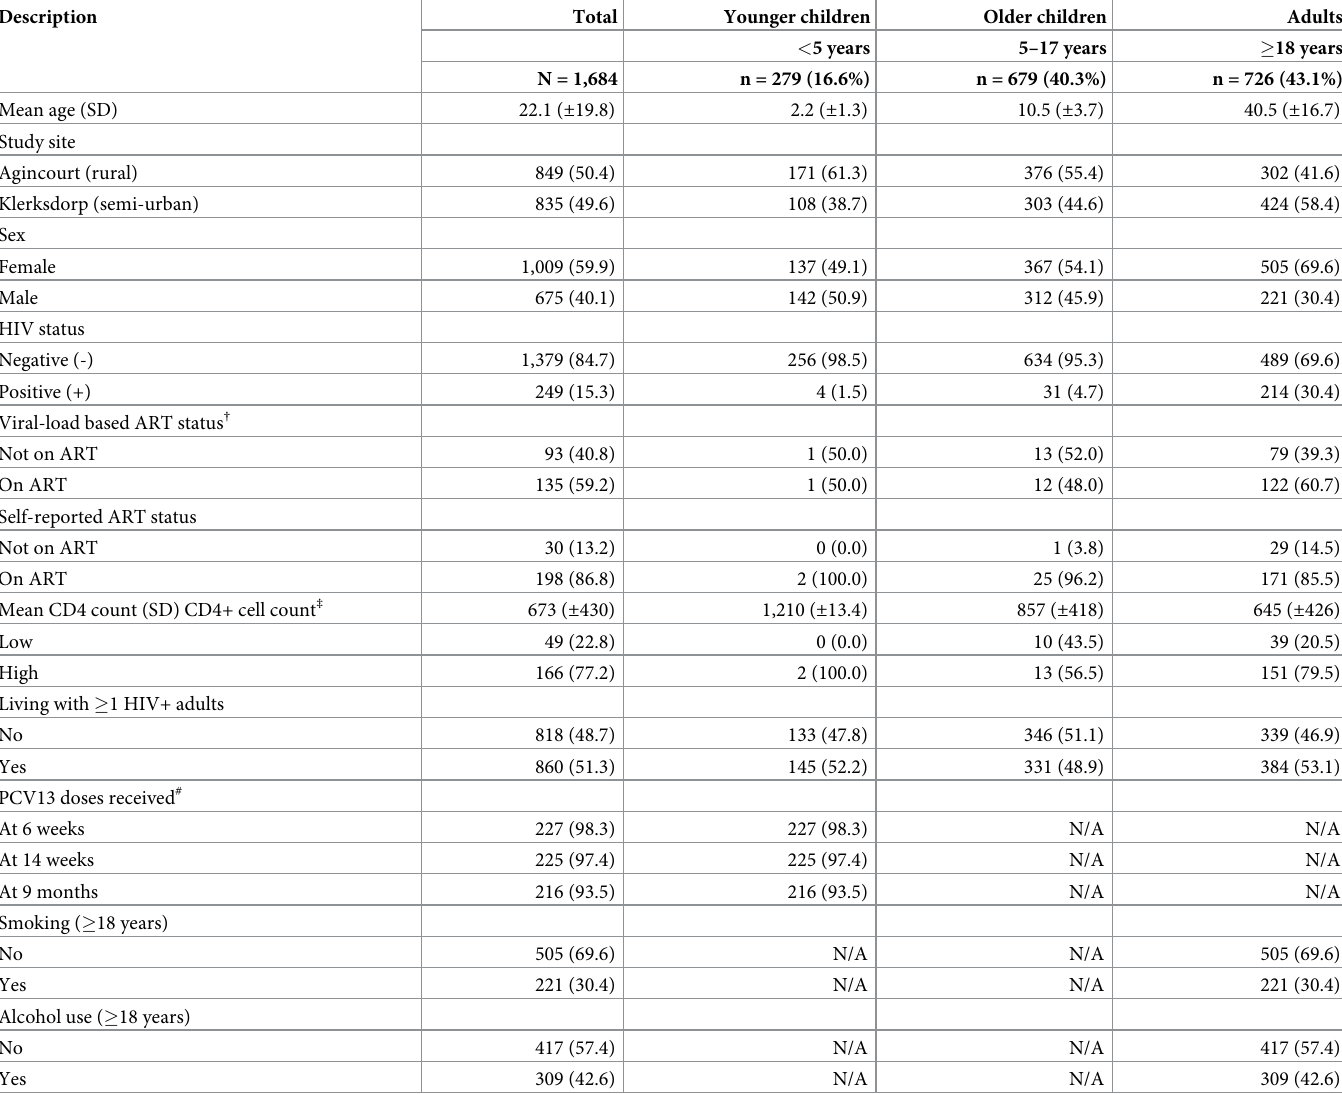
Table 1. Baseline demographic and clinical characteristics of children and adults who were followed up twice weekly for ten months for nasopharynx swabbing for pneumococcal carriage in South African households between 2016 and